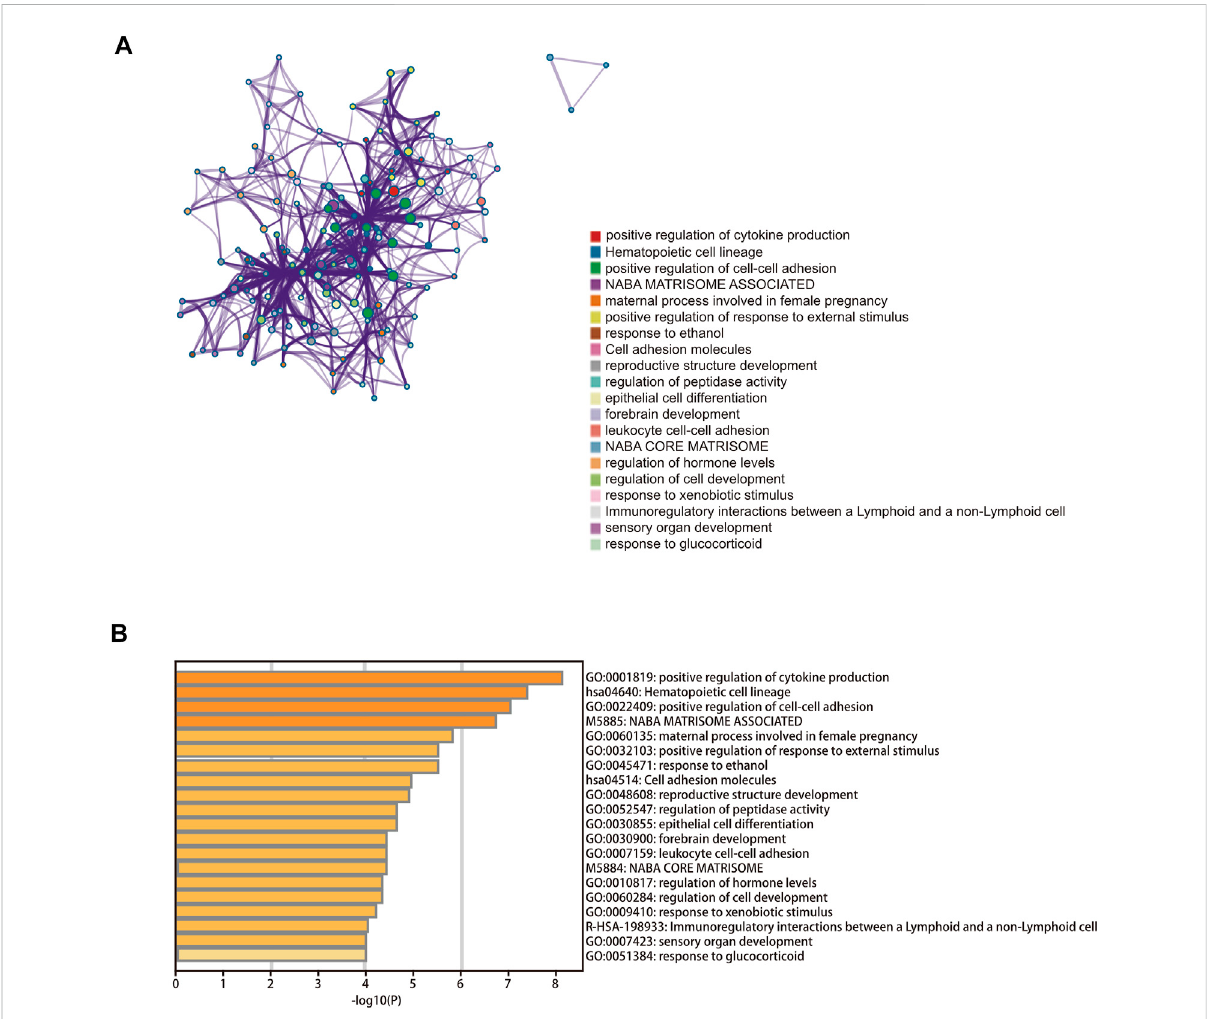
FIGURE 7 Functionalenrichmentanalysis. (A) Bargraphofenrichedtermsacrossthe100targetmRNAs. (B) Networkofenrichedtermscoloredaccording to cluster